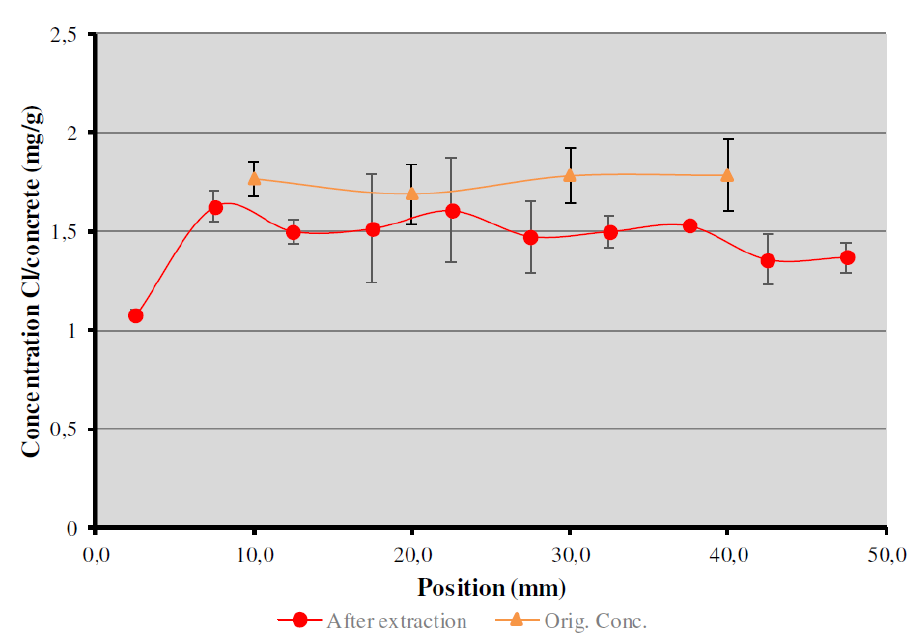
Figure 6. Concentration profile of N-1% samples before and after